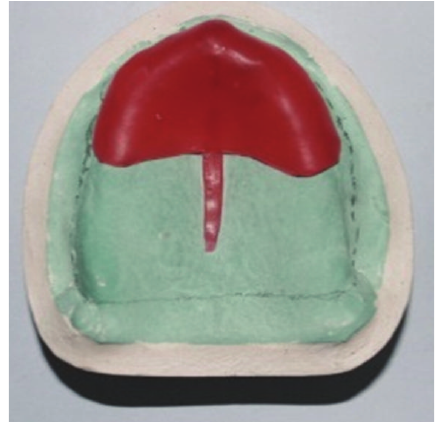
Figure 5: Relief wax placed over the maxillary arch.